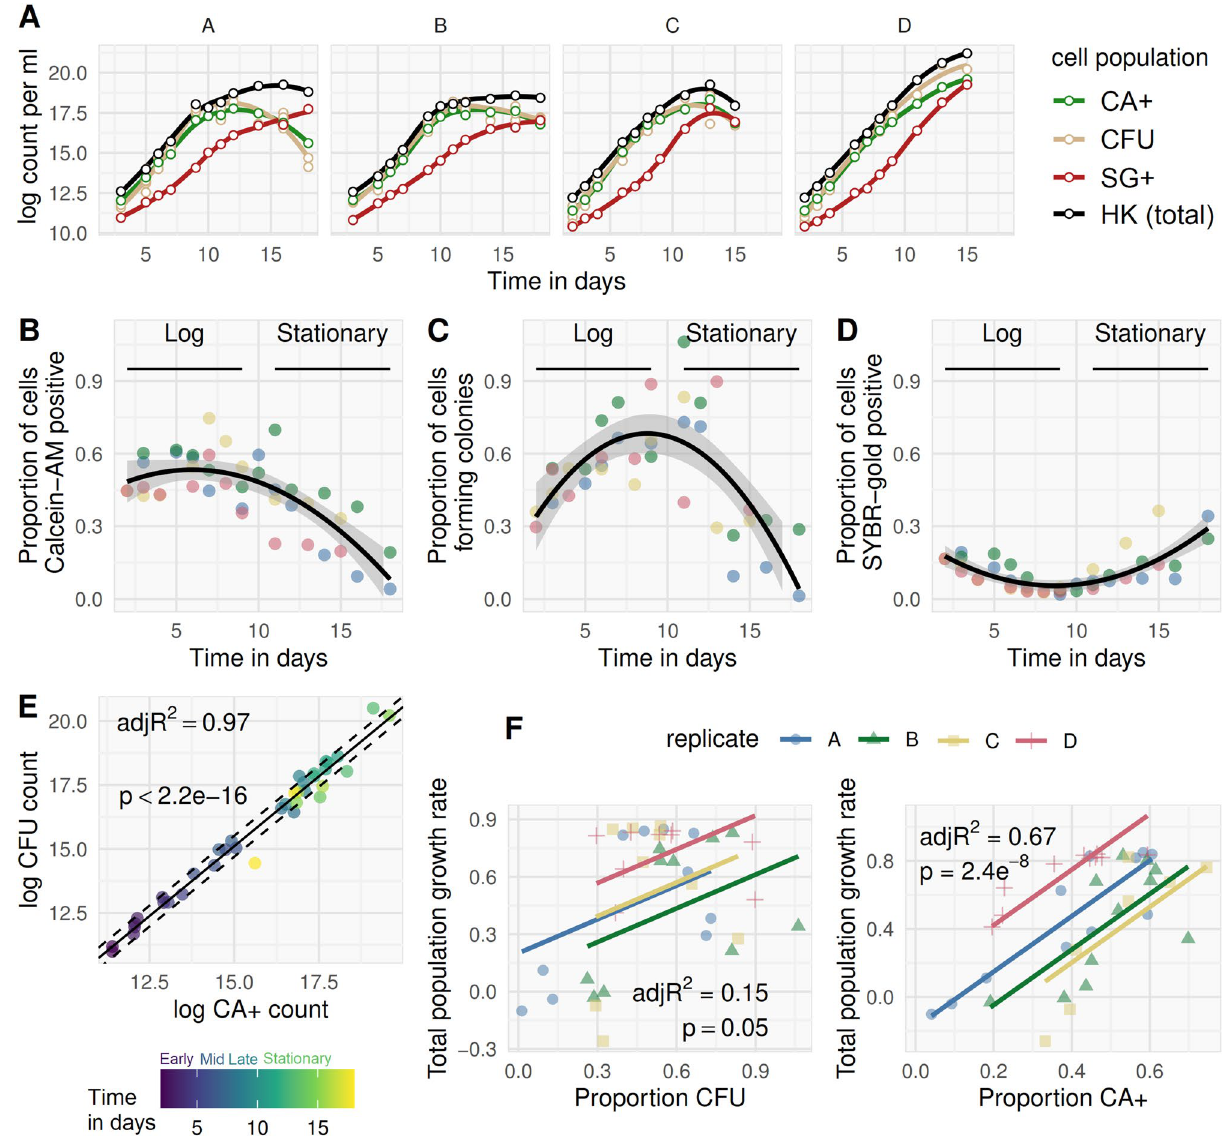
Figure 7. Bacillary population dynamics during standard growth in culture. Four independent M. bovis BCG cultures (replicates i to iv), grown in 50 ml 0.15% v/v Tween80 7H9, 500 ml tissueculture flasks at 150 rpm agitation, were serially quantified by CFU and FCM counts (method outlined in Fig. 6) between 2 and 15 days after inoculation into pre-warmed broth from a log phase starter culture. ( A ) Using the heat-killed SYBR-gold stained (HK) cell count as total cell denominator, the proportion of bacilli which were Calcein-AM positive (CA +), colony-forming (CFU), and permeable to SYBR-gold without heat-killing (SG +) are shown over time post inoculation ( B–D ); each replicate is plotted using a different colour; LOESS line-of-best-fit and 95% CI shown for the observations aggregated across replicates. Linear correlation between log CA + and log CFU counts was strong ( E ), but with a dependency on phase of growth (time in days from inoculation shown by colour; non-constant variance (NCV) test for heteroscedasticity, p = 0.03, dashed lines are +/− 1 SD of residual variation). Rate of population growth is defined as instantaneous rate of change in total cell count (slope of the tangent to the curve at a given timepoint; i.e ., first derivative of the growth curve). Rate of total population growth was regressed on proportion of bacilli able to form colonies, or on proportion CA + ( F ), at any given timepoint, with each replicate (i to iv, again shown by colour) allowed to differ by intercept but not